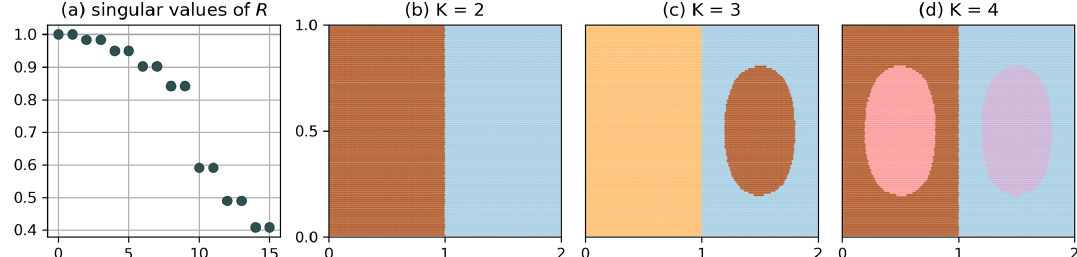
Figure B1. Clustering of Q for the autonomous double gyre with (cid:49)x = (cid:49)y = 0 . 1, i.e. an optimal partition, and the simultaneous K -way NCut (algorithm 1 in Sect. 3.3). The singular values are doubly degenerate as the network Q consists of two disconnected sets.